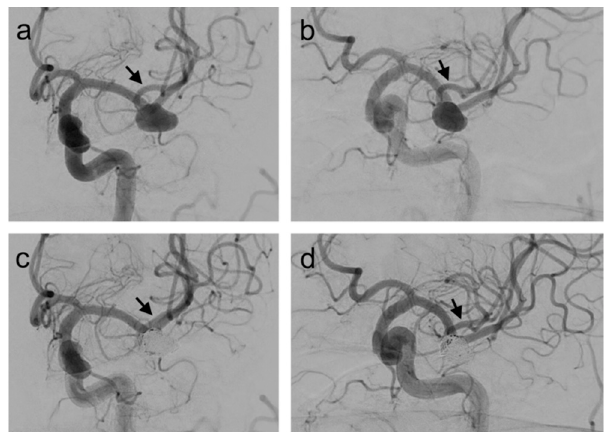
Figure 3. ( a , b ) A patient with a wide-necked left MCA bifurcation aneurysm. The aneurysm was treated with the stent-assisted coiling using the LVIS Jr. and coiling through the stent mesh; ( c , d ) post-procedural DSA showing complete occlusion of the aneurysm. Notice that the stent implantation resulted in the modification of the angle between the bifurcation branches (arrows).